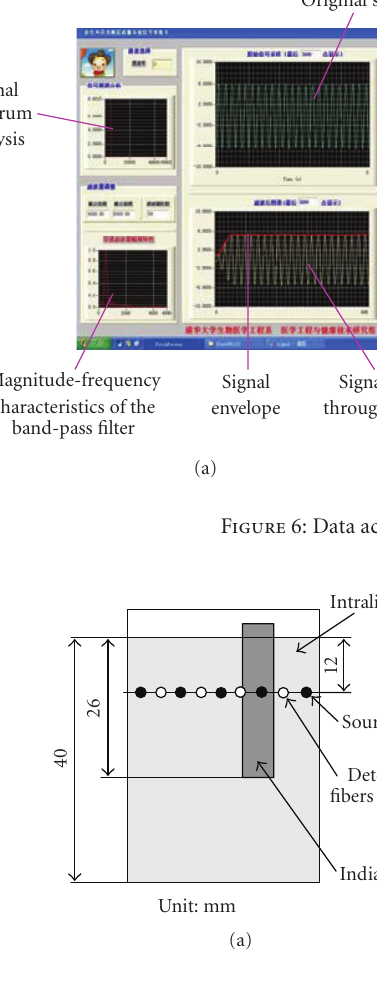
Figure 7: An experimental